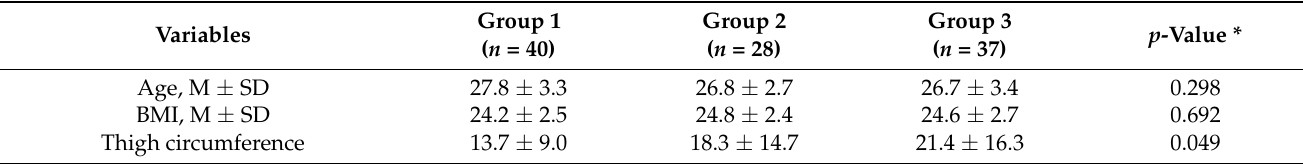
Table 1. Patients’ characteristics among